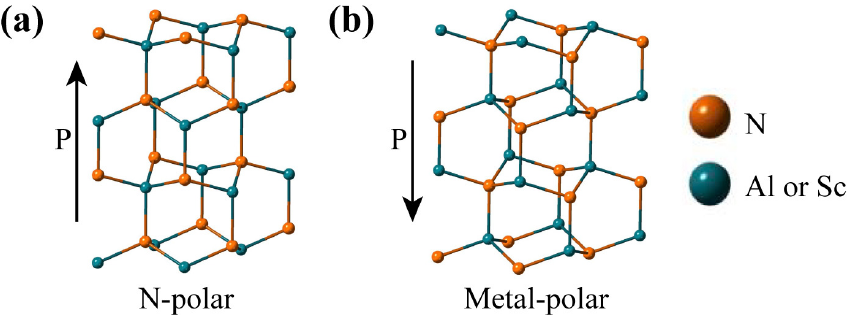
Figure 1. The two polarization states formed when the scandium atom occupies the position of the aluminum atom: ( a ) N-polar and ( b )